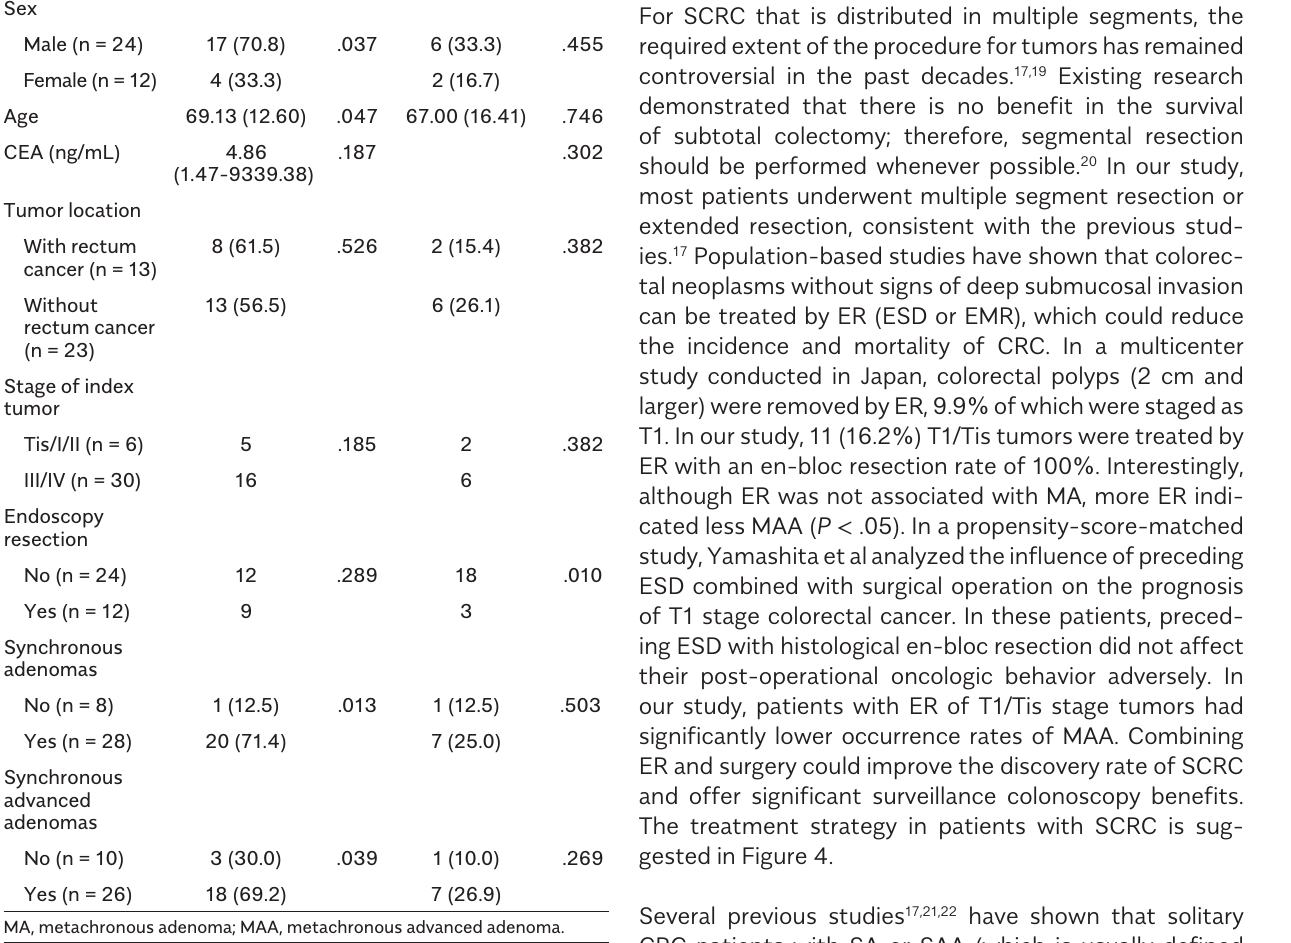
Table 3. Predictors of Metachronous Adenoma and Metachronous Advanced Adenoma During Follow-up Any MA (n, %) P Any MAA (n,